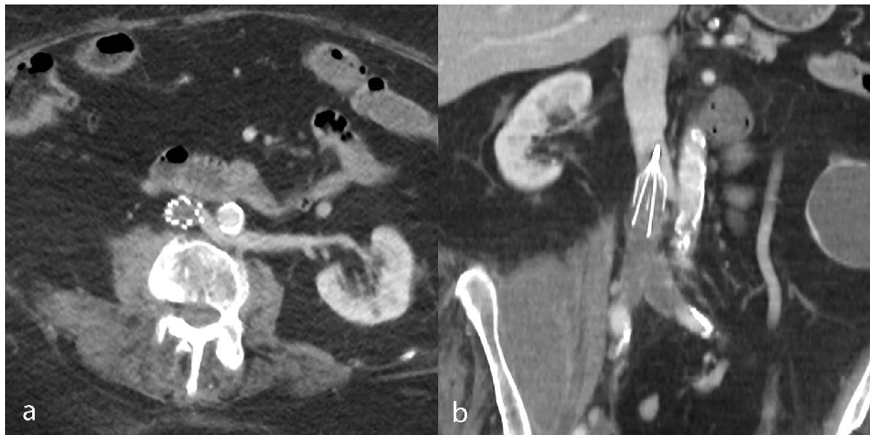
Figure 4. CT venography obtained one month after IVCF placement shows filter tilt and acute DVT of the iliac veins and infrarenal IVC on axial ( a ) and coronal reformatted image ( b ), leading to technical ineligibility for retrieval. CT computed tomography, DVT deep venous thrombosis, IVC inferior vena cava, IVCF inferior vena cava